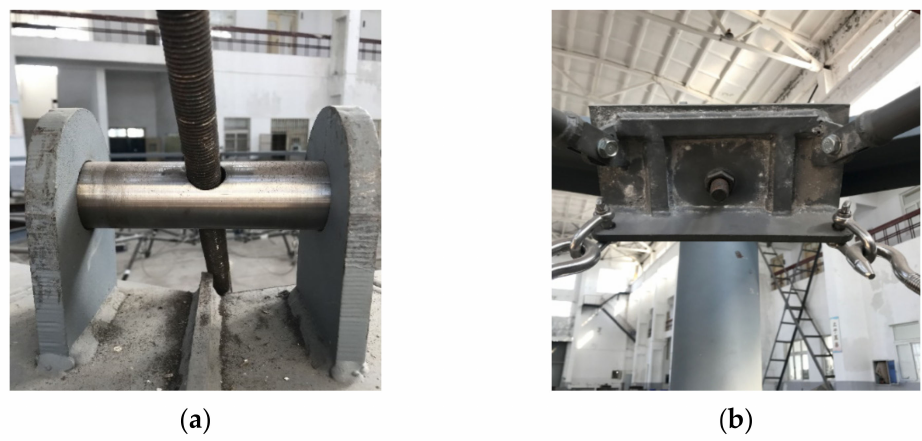
Figure 5. Details of the boundary nodes. ( a ) Support node; ( b ) Gusset